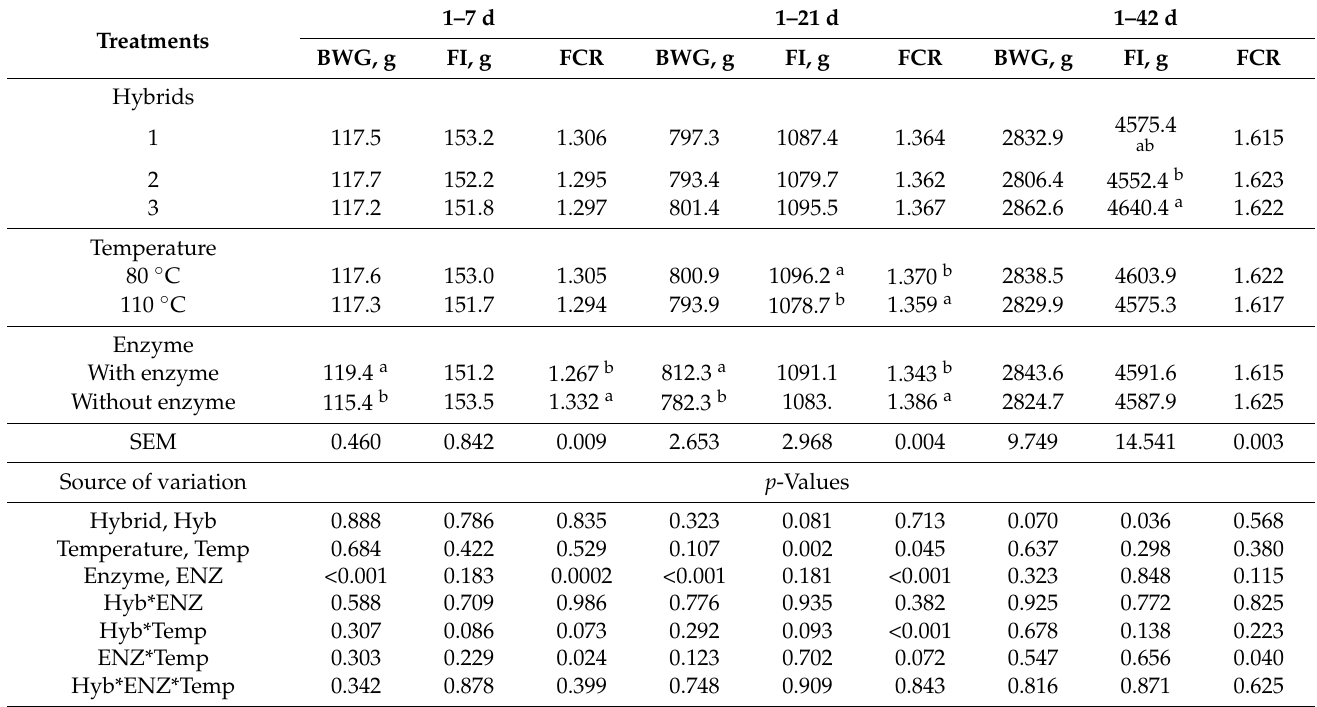
Table 2. Performance of broilers fed diets containing different corn hybrids, dried at two temperatures, and with or without the inclusion of an enzymatic